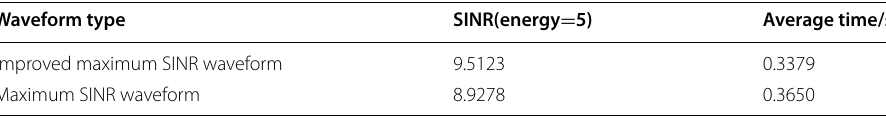
Table 2 The output SINR and average time for solving Lagrange